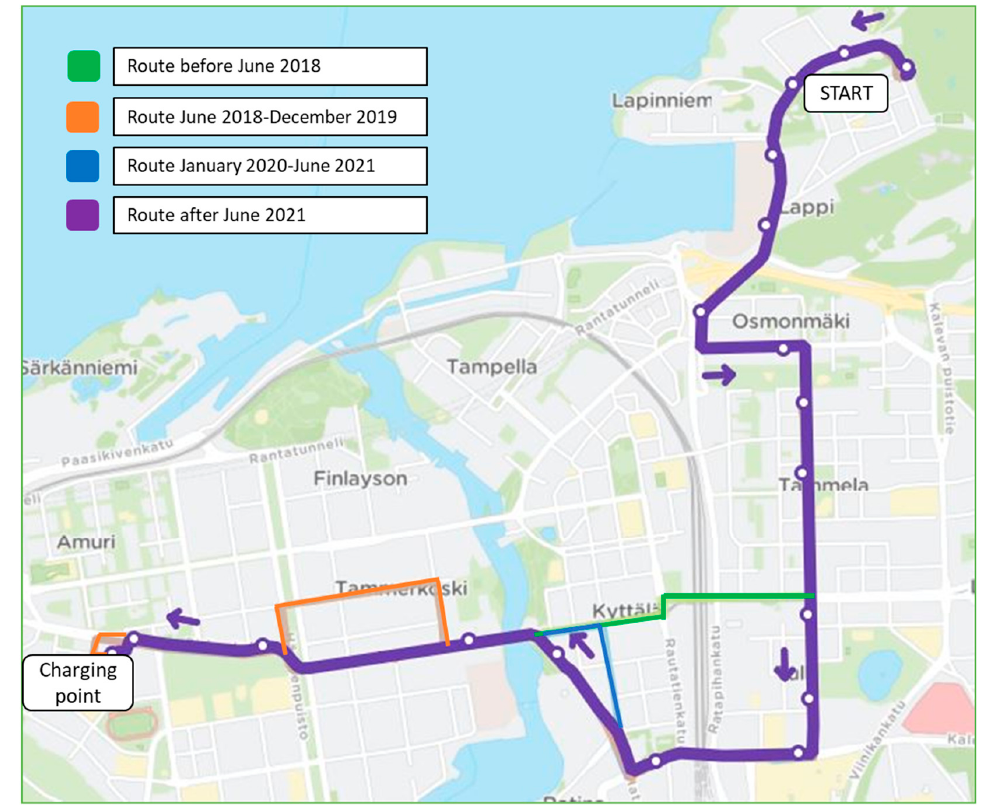
Figure 3. Line 2 changes due to the tram site.